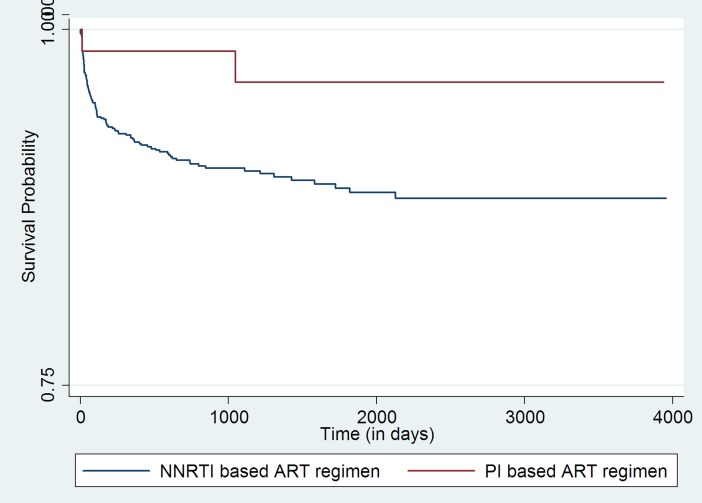
Unadjusted Kaplan-Meier survival curves for treatment outcome of HIV positive children who receiving ART in Mingalardon Specialist Hospital by regime of ART patients (2006 to 2016).Log rank test chi2 p-value: 0.0531.